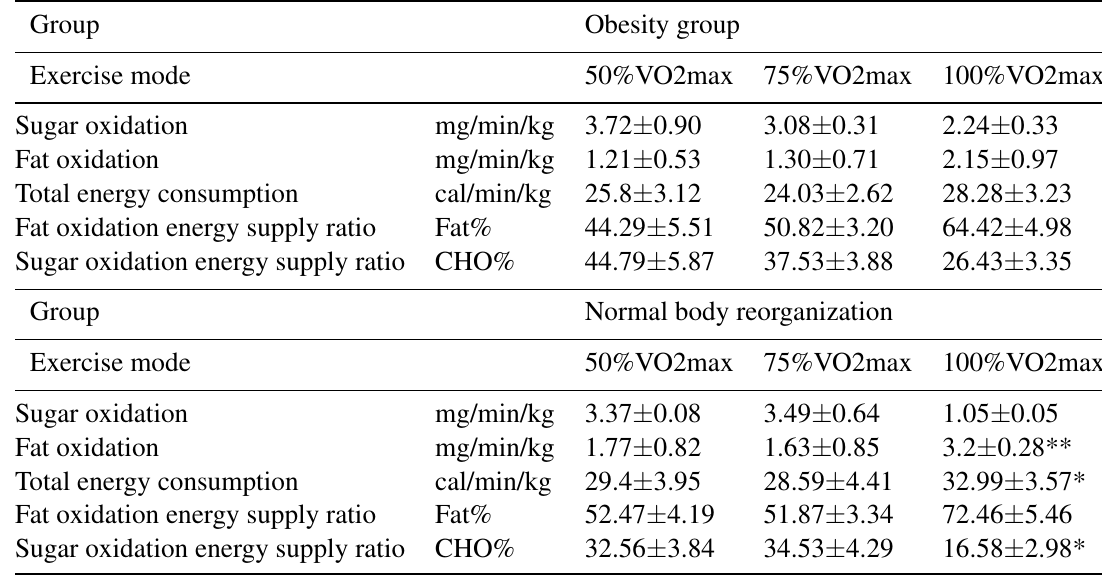
Table 5 Comparison of substrate metabolism and energy consumption during the recovery period (30min) between the obese group and the average body with different exercise methods.